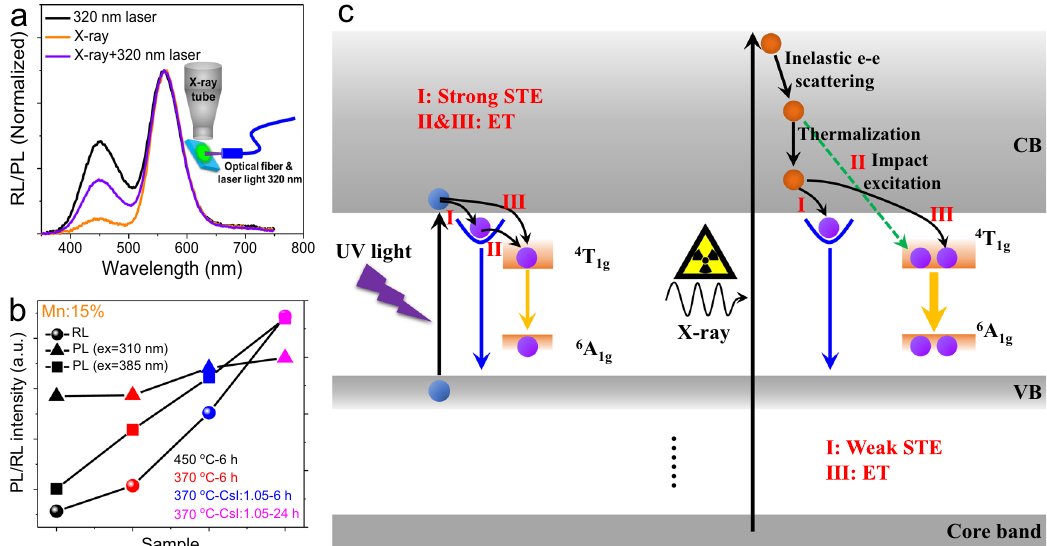
Fig. 3 Proposed PL and RL mechanism. a Luminescent spectra of thick Mn15% fi lm under the excitations of X-ray, 320 nm laser or both. The inset shows the measurement system focused on the same point. b PL and RL intensity of Mn15% with various reaction parameters under different excitations of X-ray, 310 nm, and 385 nm, respectively. c Proposed PL and RL mechanisms including STE, ET, and impact